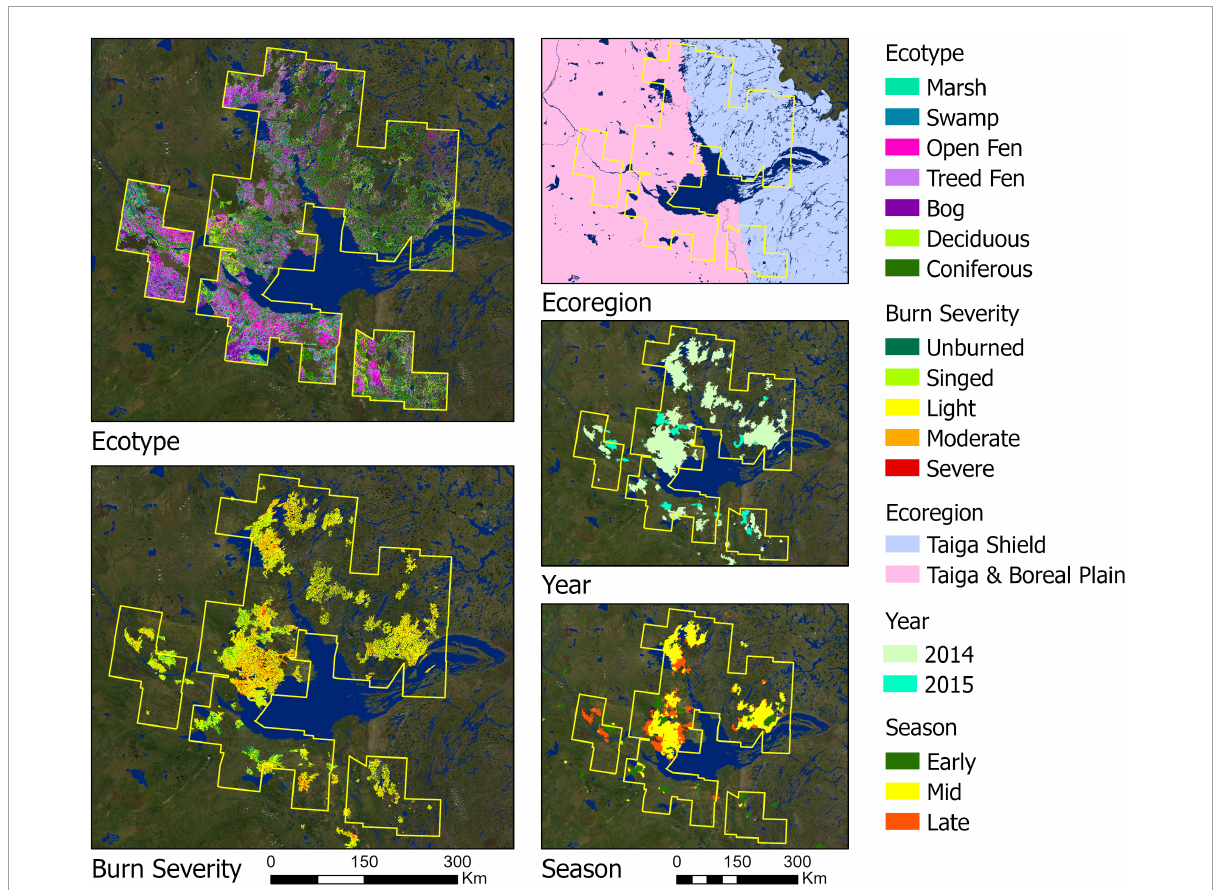
FIGURE4 Study parameters were parsed by ecoregion consisting of Taiga plains and Taiga shield, by year for the 2014 and 2015 wildfire perimeters, by season for early, middle, and late season fires, and by ecotype.